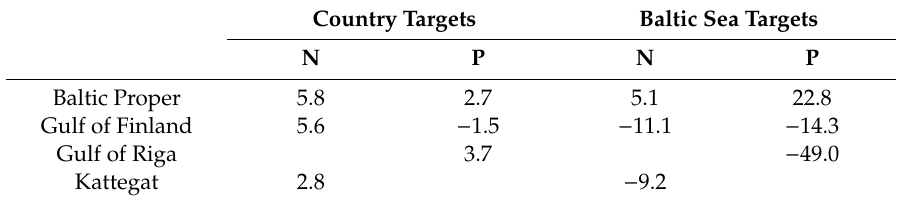
Table 4. Deviations from marine basin load targets under the country and Baltic Sea targets, % from basin load